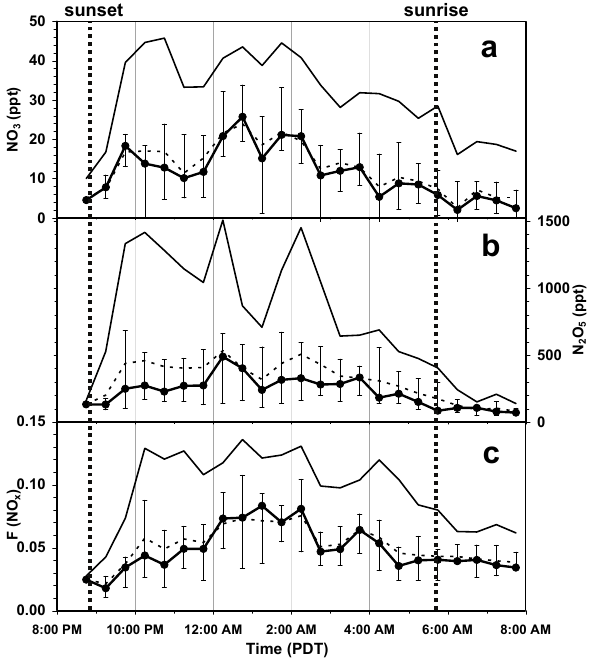
Fig. 3. Observations of NO 3 and NO 2 and calculated N 2 O 5 at East Point, 2005.